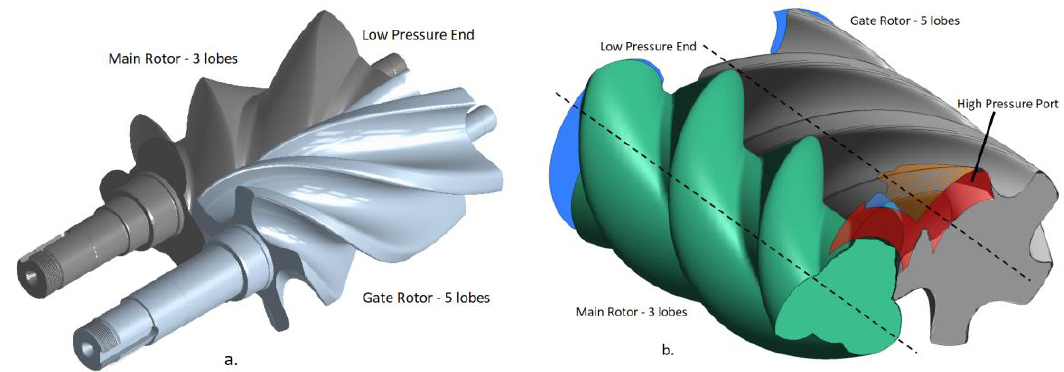
Figure 3. Non-conventional variable geometry twin screw rotors with a N 3–5 profile: ( a ) variable lead, ( b ) variable rotor profile [1,7].